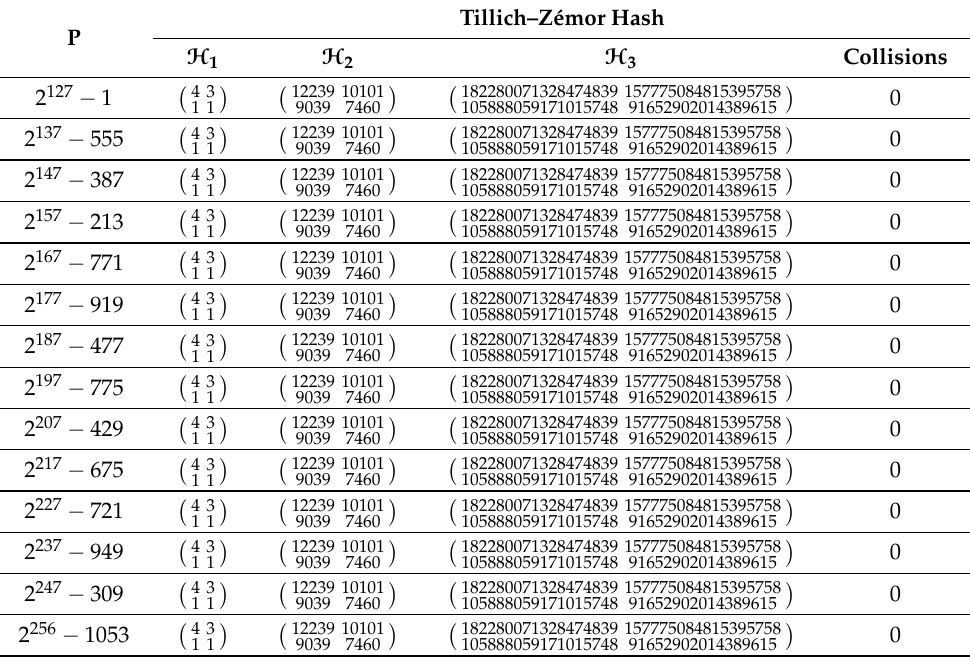
3 give Tillich–Zémor hash values of Brauer messages M i i ≤ ≤